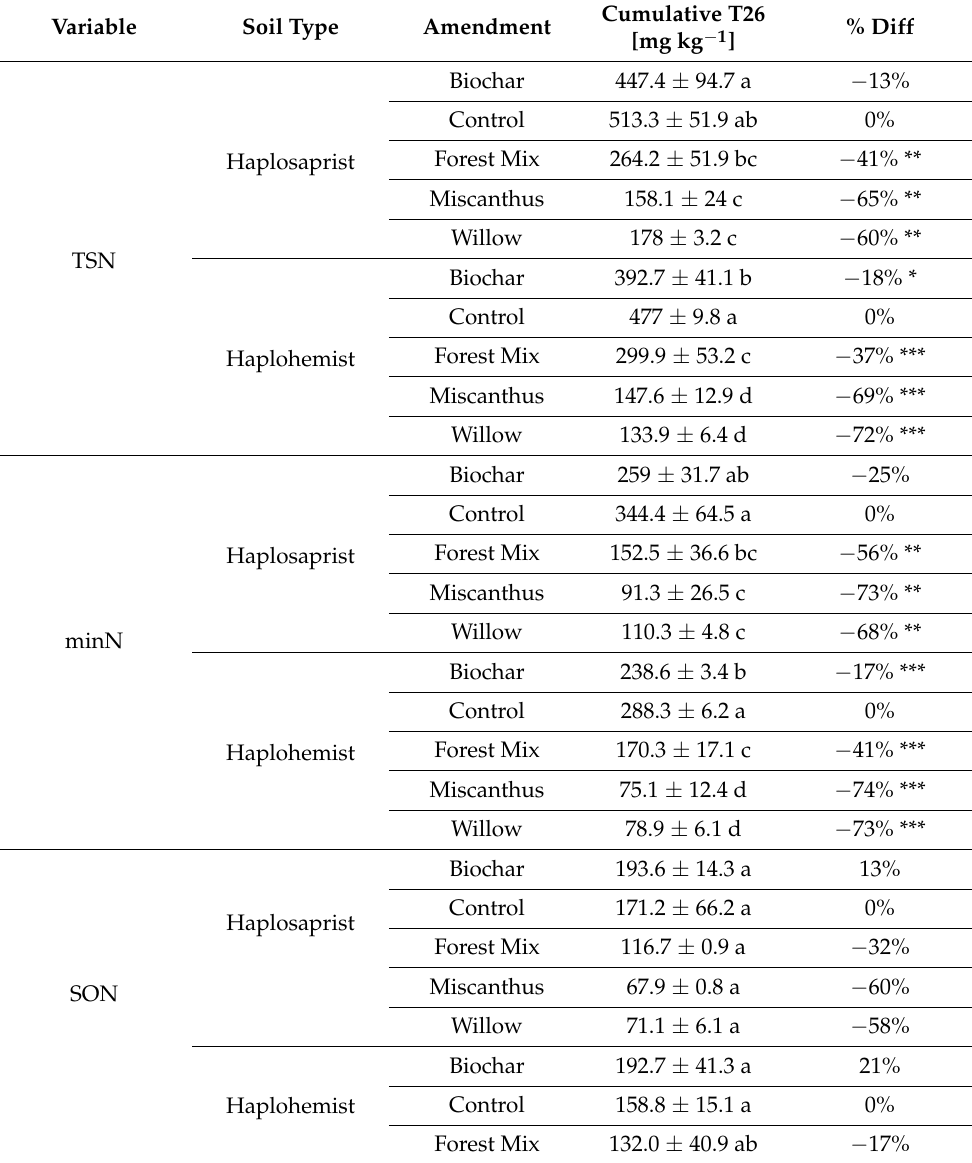
Table 4. Cumulative (after 26 weeks of incubation) measured TSN, minN and calculated SON in mg kg − 1 with the standard deviation to the mean calculated with three